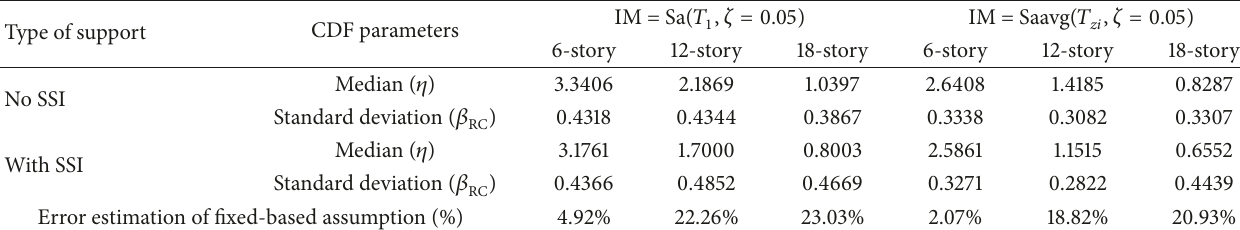
Table 5: Mean and standard deviation of fragility curves of the studied buildings in different states. Type of